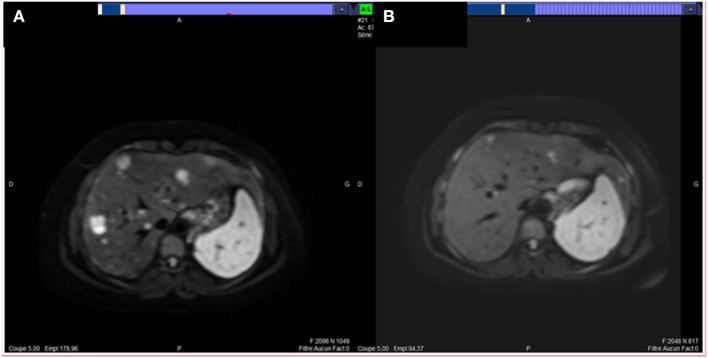
MRI images of liver metastases of our second case of pancreatoblastoma (patient # 2) before (A) and after four cycles (B) of FOLFIRINOX regimen: partial response.